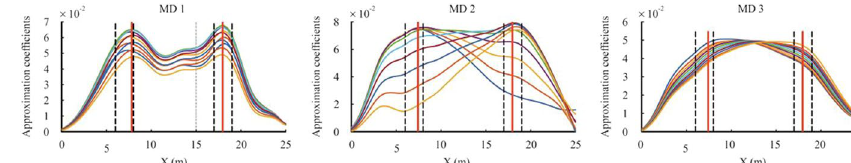
Fig. 13 The ninth order approximation coefficient curve of the signal in the direction of the X axis for 3 multiple damage scenarios in the noise-free mode